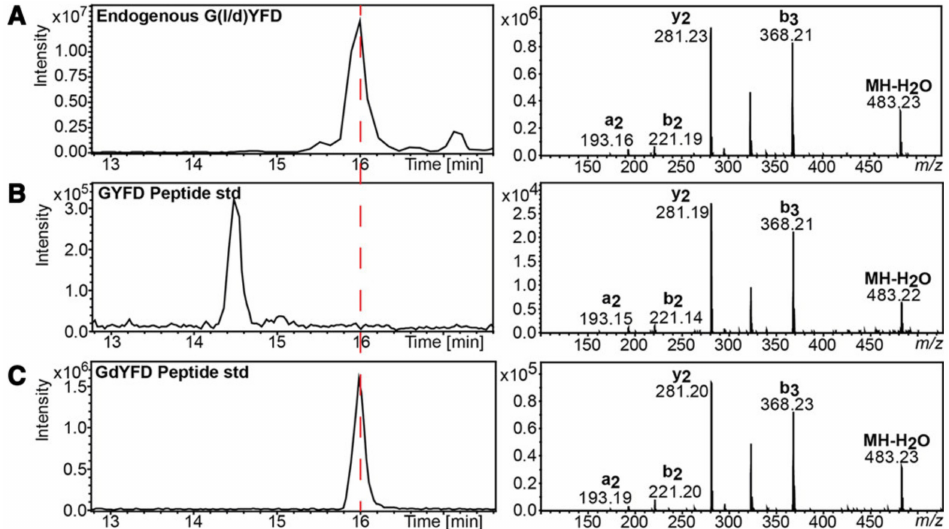
Figure 2. LC–MS analysis of DAACP isolated from Aplysia californica , the retention times of the indigenous ( A ) and synthetic DAACP ( C ) are identical and are different from the peptides with all L-amino acids ( B ). However, the MS profiles of the three peptides are similar. Reproduced with permission from